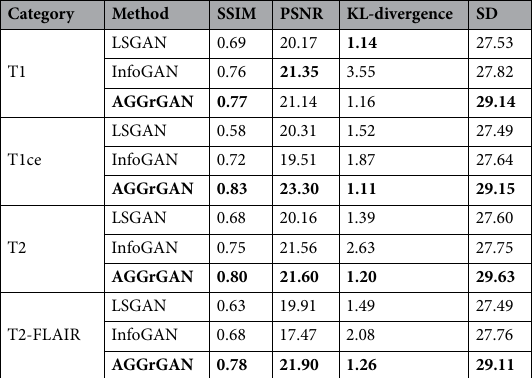
Category Method SSIM PSNR KL-divergence SD